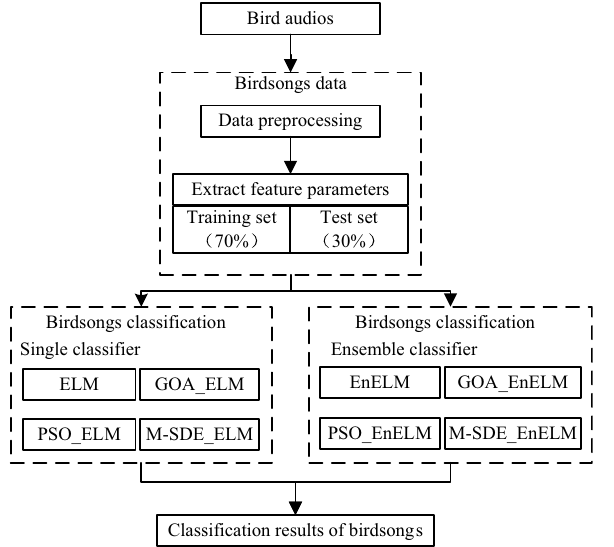
Figure 6. Experimental design process.